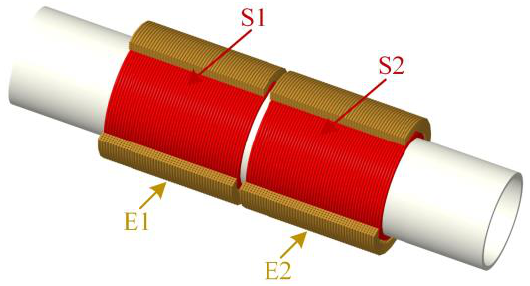
Figure 6. The sensor structure model: E1 and E2 are excitation coils; S1 and S2 are sensing coils.